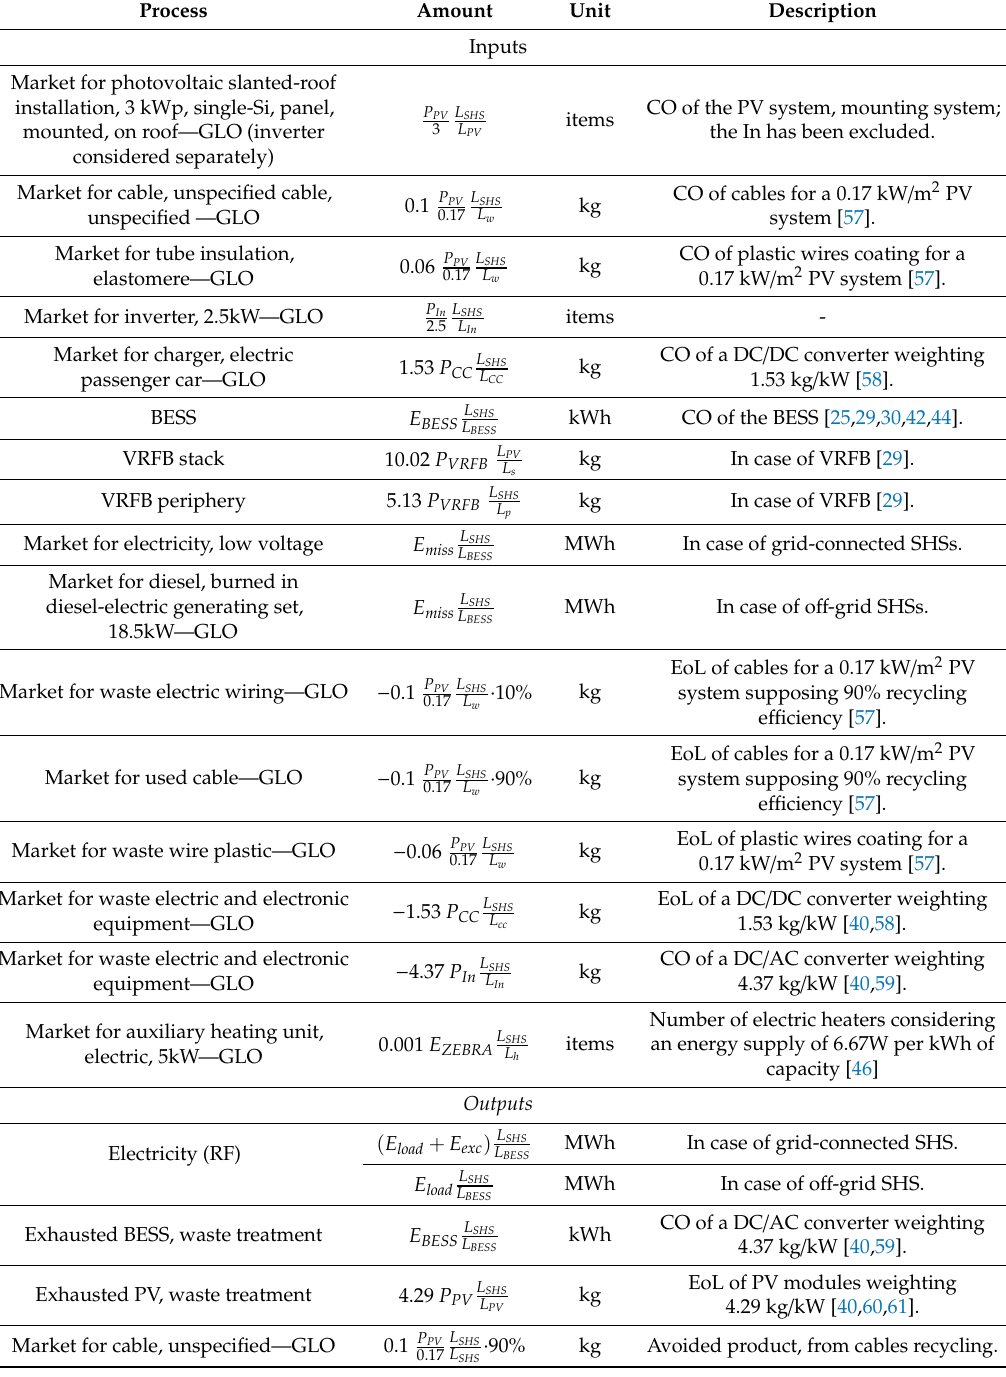
Table 5. LCI of the